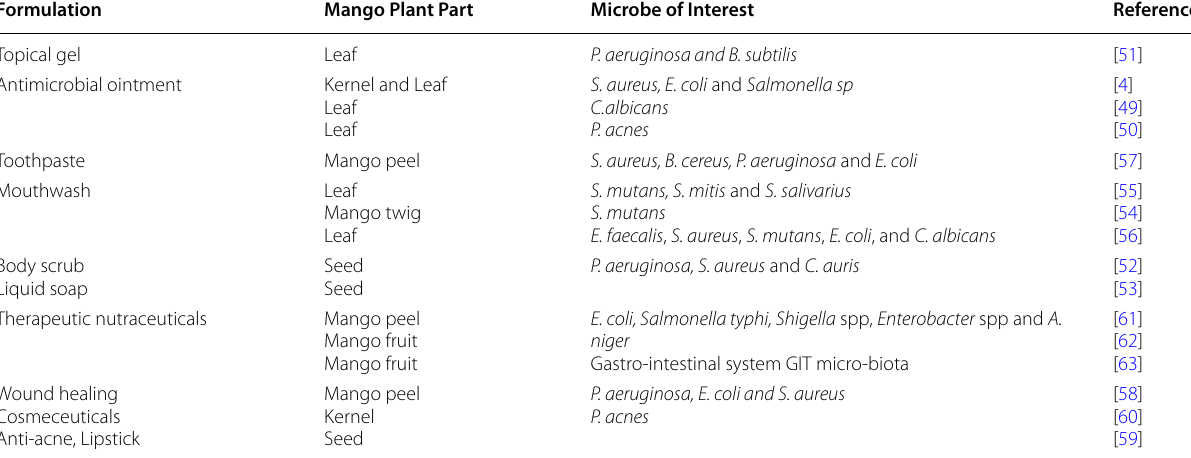
Table 2 Summary of selected antimicrobial formulations from mango plant parts